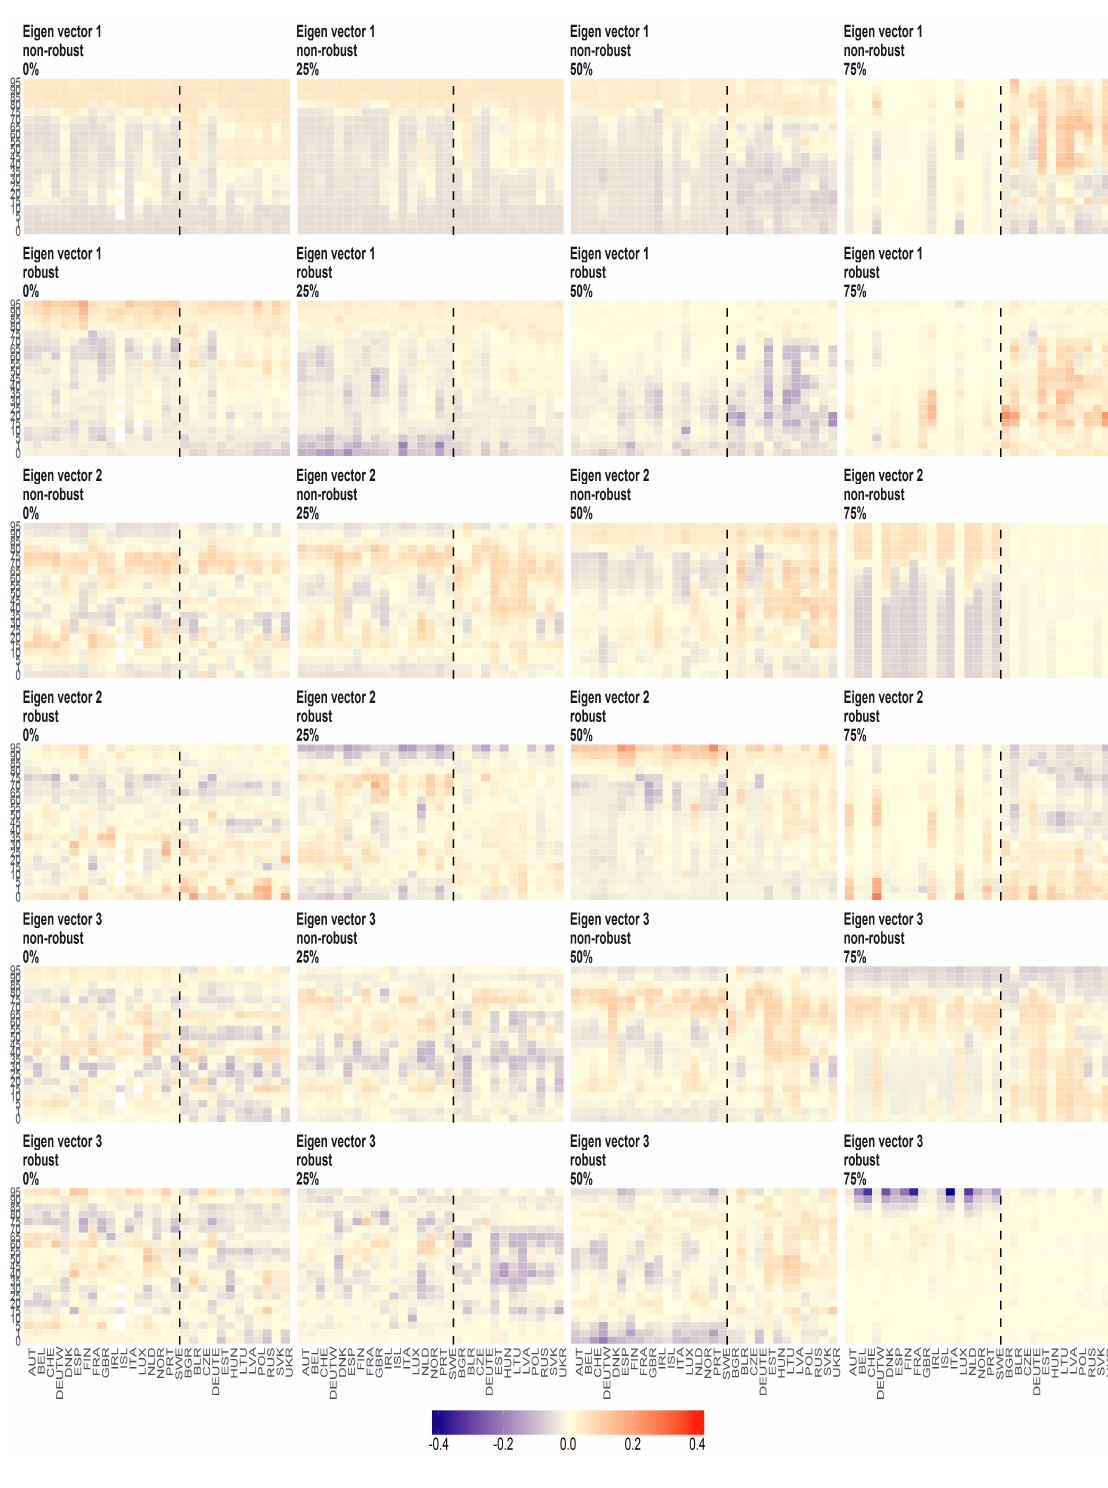
Figure 19. The eigenvectors of Death counts (y axis) over age groups (y axis) and countries (x axis) obtained using PPCA for Females. Every row of subfigure corresponds to different eigenvector. Every column corresponds to different level of maximum missing values per observation (0%, 25%, 50% and 75%). The blue line corresponds to robust standardisation whereas red line to non-robust standardisation of